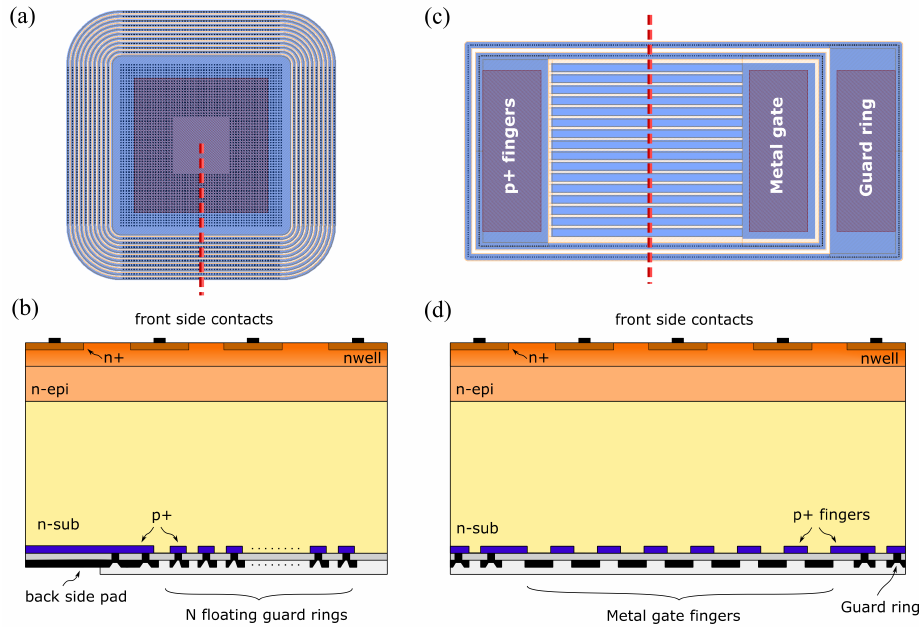
Figure 6. ( a ) Layout of a backside diode with floating guard rings. ( b ) Schematic cross section of a backside diode with floating guard rings. ( c ) Layout of a gated diode with dedicated guard ring. ( d ) Schematic cross section of a gated diode with dedicated guard